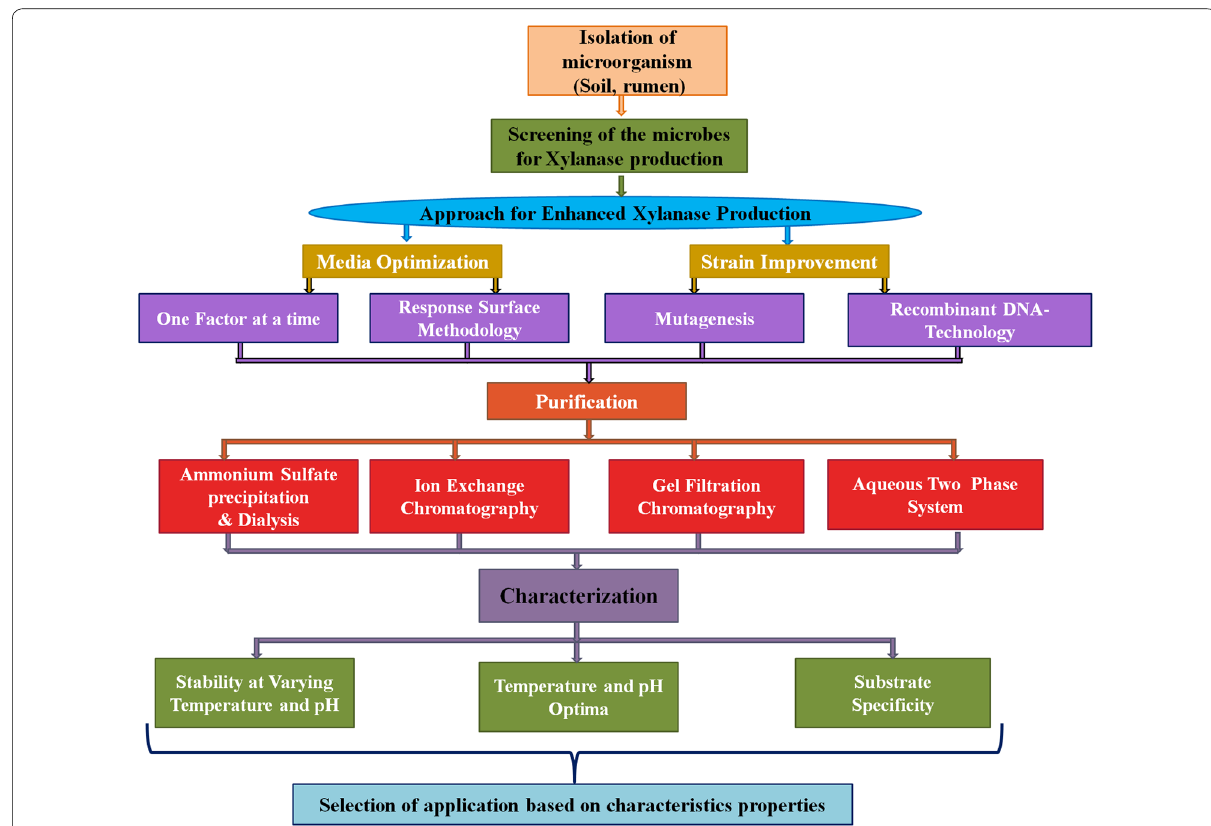
Fig. 5 Schematic representation of the methodology for production, purification and characterization of